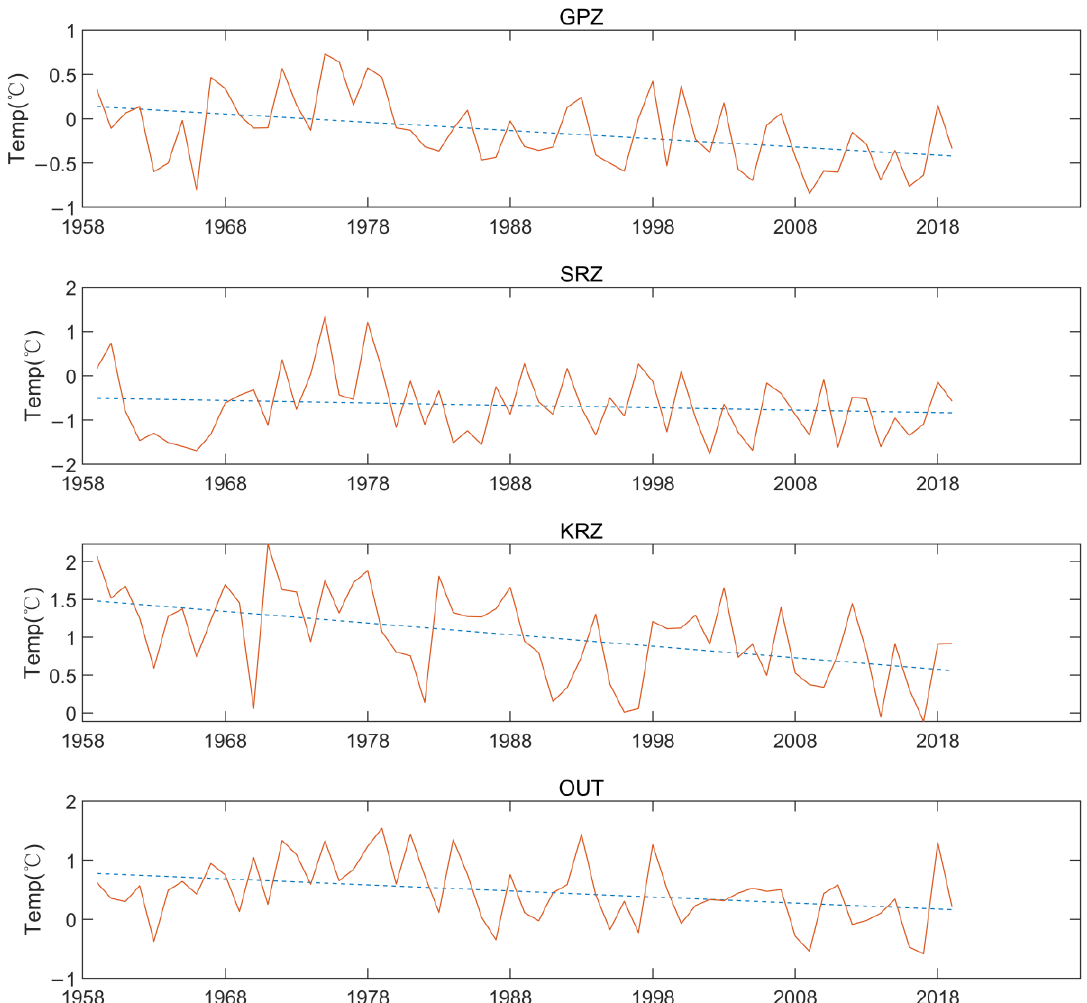
Figure 8. Annual variations of temperature in February in the different MPA